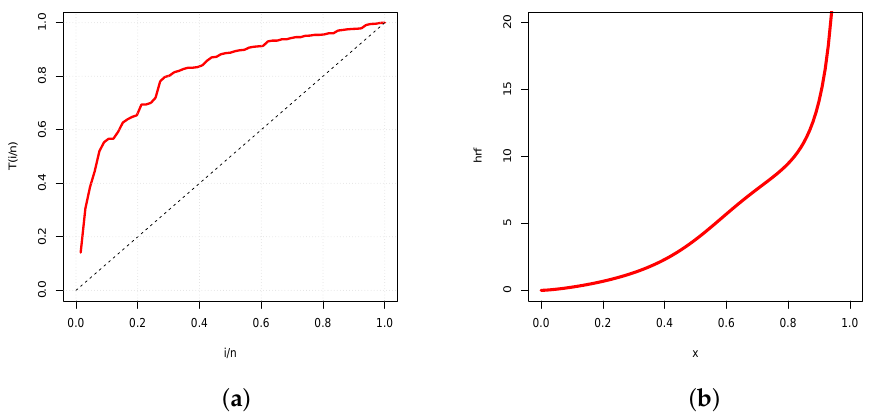
Figure 9. Plots of the ( a ) TTT plot and ( b ) estimated hrf of the UG/G model for the trade share data